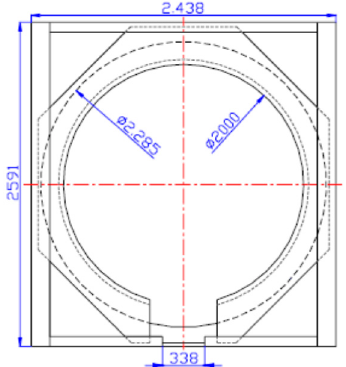
Figure 4. Upper view.